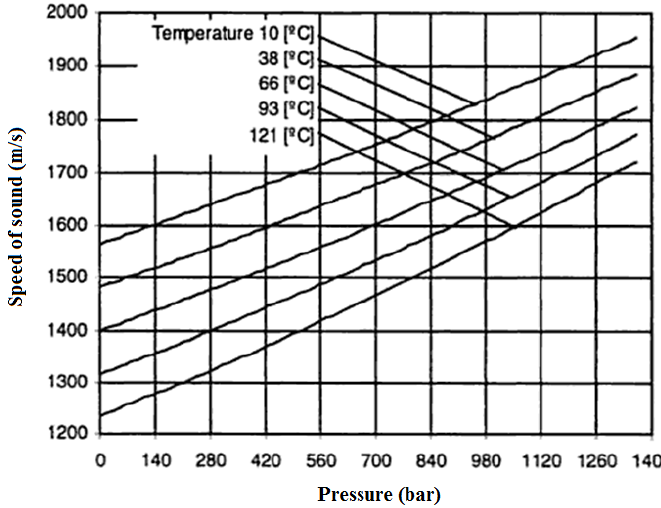
Figure 21. The speed curve of sound in mineral oil [45].